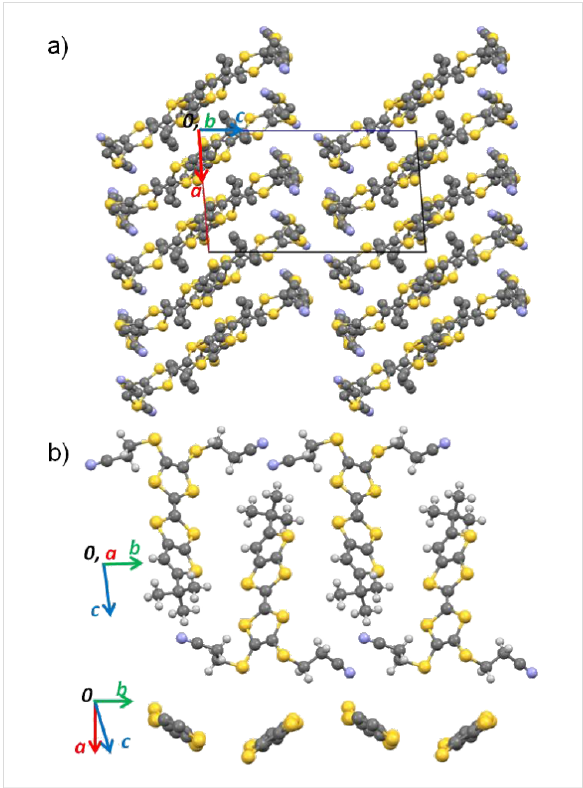
Figure 6: Crystal structure of 1 a) view along the b axis ; b) Partial view of one chain in the b,c plane (top) and of the same chain showing the tilt between the molecules along the chain direction (bottom – the cyanoethyl and tert -butyl groups were omitted for